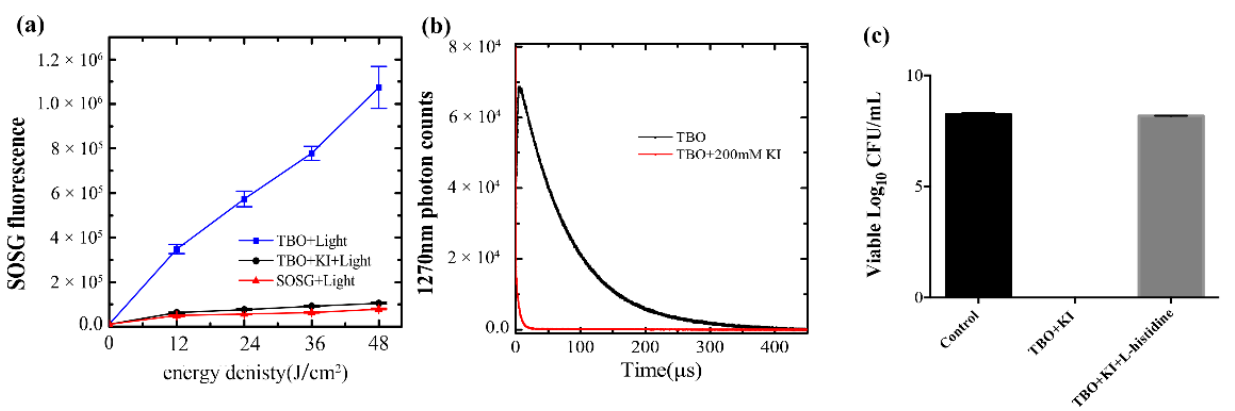
Figure 4. ( a ) 1 O 2 detection by singlet oxygen sensor green (SOSG) fluorescent probe. ( b )